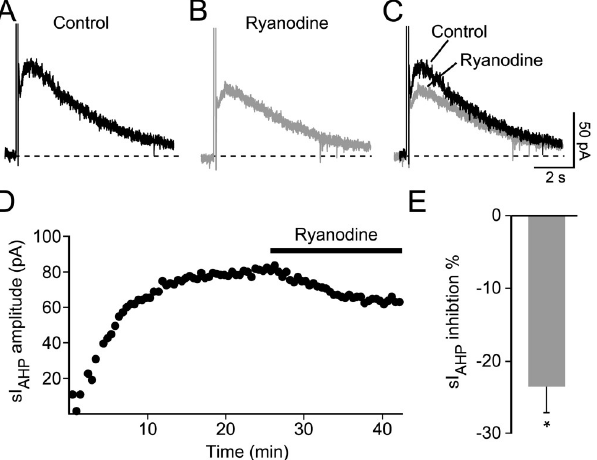
Fig 2. Effect of ryanodine on the sI AHP measured at steady state in rat CA1 pyramidal neurons. (A) Representative sI AHP trace measured at steady state. (B) Reduction of the sI AHP upon application of ryanodine (10 μ M). ( C) Superimposed traces before and after application of ryanodine. ( D) Time course of action of ryanodine (10 μ M) on the sI AHP amplitude in the same cell as for the traces shown in panels A-C . (E) Summary bar diagram showing that ryanodine decreases the amplitude of the sI AHP by 23.3 ± 3.7% (n = 5; P = 0.03). Data are normalised to the control, set as